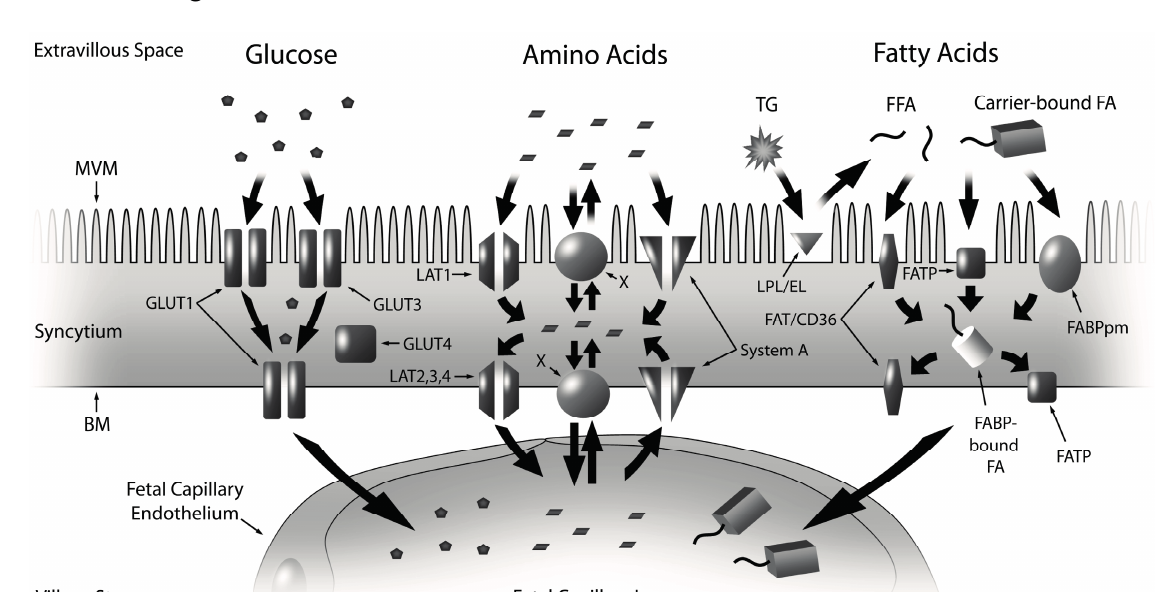
Figure 1. Nutrient transport across the placenta, featuring the SCTB and the fetal endothelium, and the location of key proteins involved in macronutrient (glucose, amino acids, fatty acids) transport at the MVM and BM. The SCTB is bathed in maternal blood on the apical surface instigating substrate transport at the MVM. This is followed by movement of the nutrients through the cytoplasm of the intermembrane space and interaction with the BM prior to uptake by the fetal capillary endothelium on the opposing side. Glucose is transported across the MVM and BM primarily by GLUT1. The accumulative transporters, System A, mediate the uptake of small neutral amino acids across the MVM and BM into the syncytium. Amino acids are transported across the BM towards the fetal capillary by System L facilitated transporters (TAT1, LAT2, 3 and 4) and exchangers. The exchangers, transport one amino acid in exchange for another, and thus they are dependent on the activity of the accumulative and facilitative transporters. LPL and EL hydrolyze maternal (TG) into FFA that cross the MVM through FATPs, FAT/CD36 and FABPpm. FFAs are trafficked through the cytosol via FABPs and across the BM by FATPs and